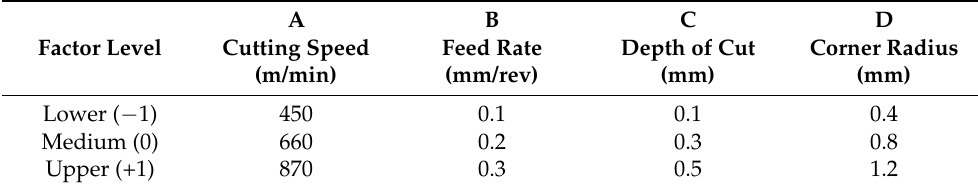
Table 1. Values of input factor levels.